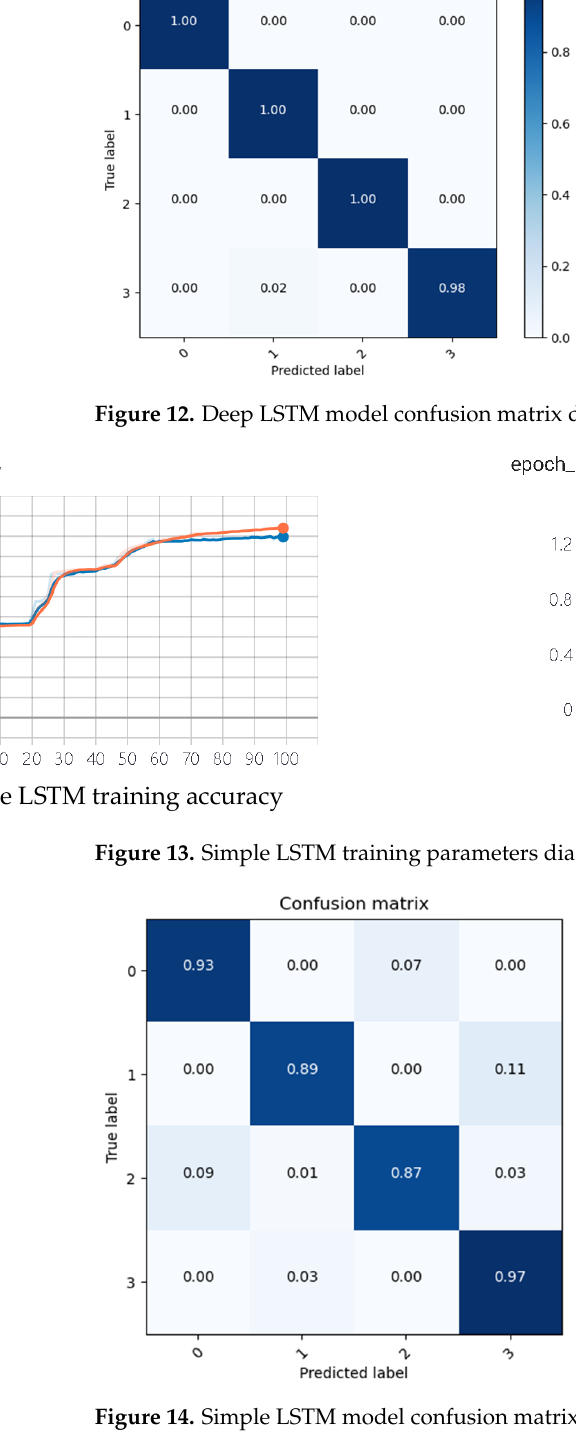
Figure 14. Simple LSTM model confusion matrix diagram.